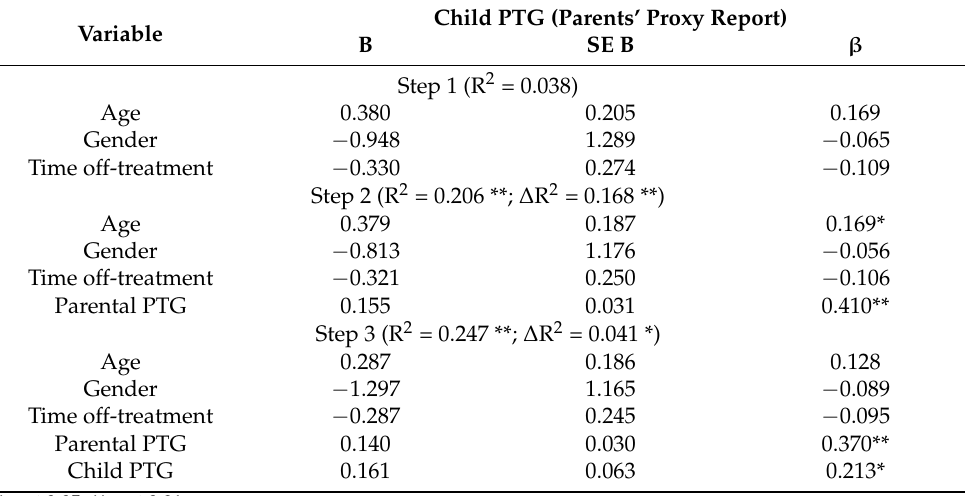
Table 4. Results of the multiple regression analysis.